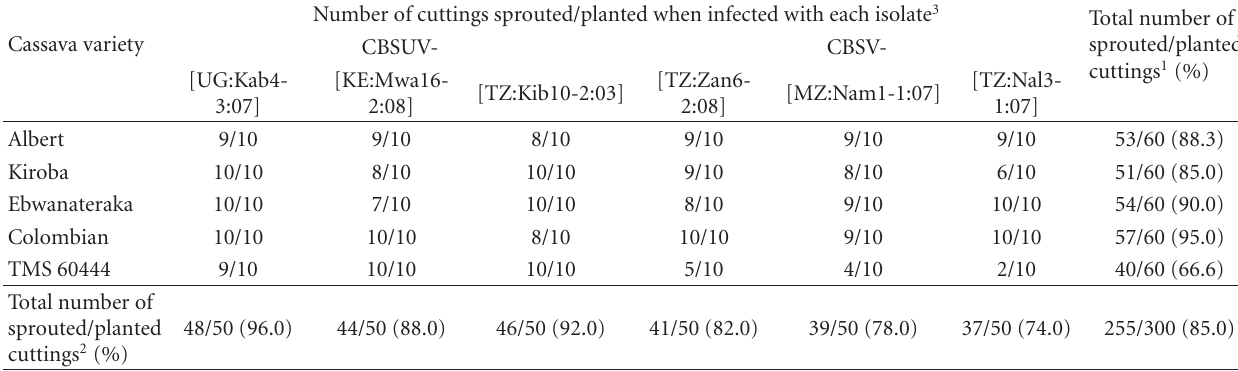
Table 4: The e ff ects of CBSD infections on the sprouting of cassava stem cuttings. Number of cuttings sprouted/planted when infected with each isolate 3 Cassava variety